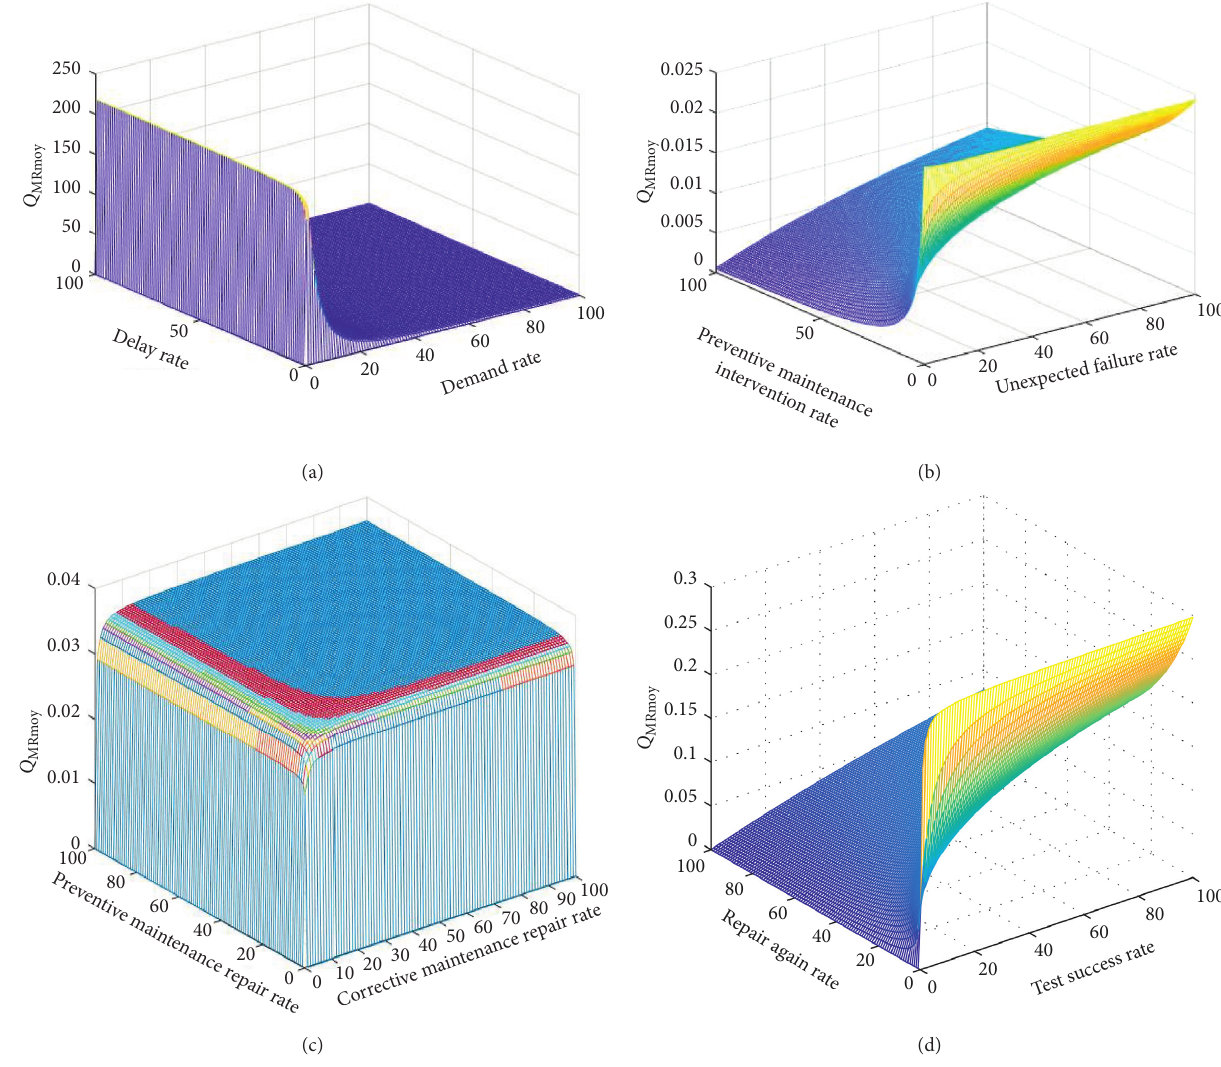
Figure 13: Bad repair quality. (a) Variation of demand and delay rates. (b) Rate variation of unexpected failure and maintenance in- terventions. (c) Repair rate variation for corrective and preventive maintenance. (d) Test rate variation (repair again or not). Table 5: The case study